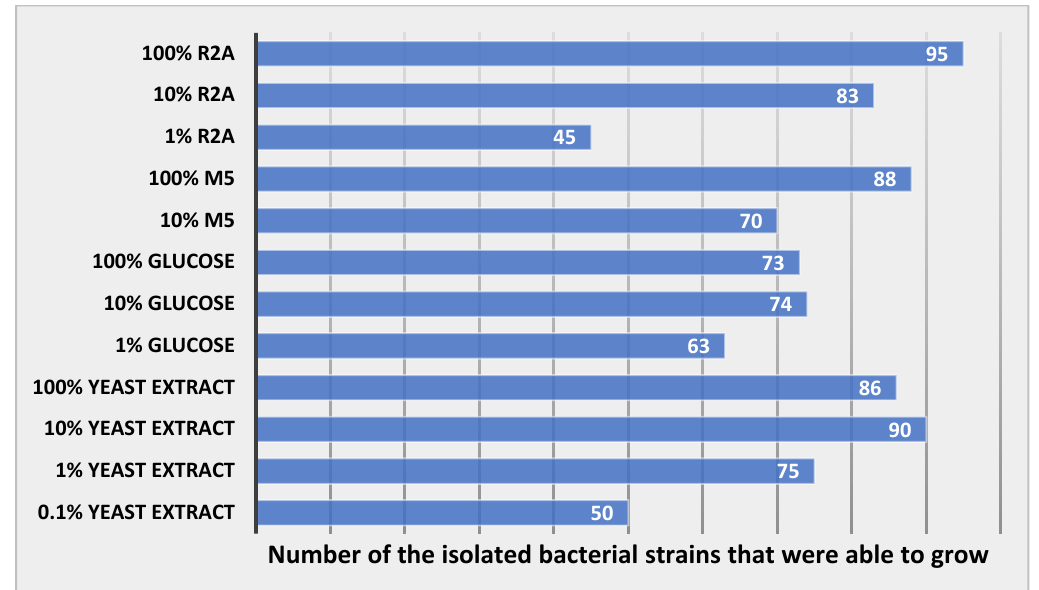
The number of bacterial strains that were able to grow at the different nutrient concen- trations was calculated, and results are shown in Figure 5.